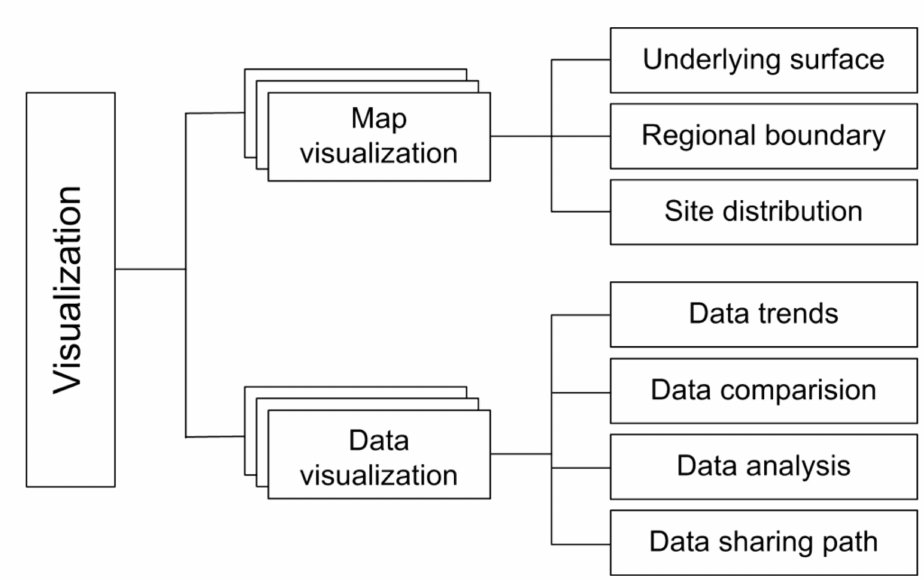
Figure 7. Data visualization function system in the